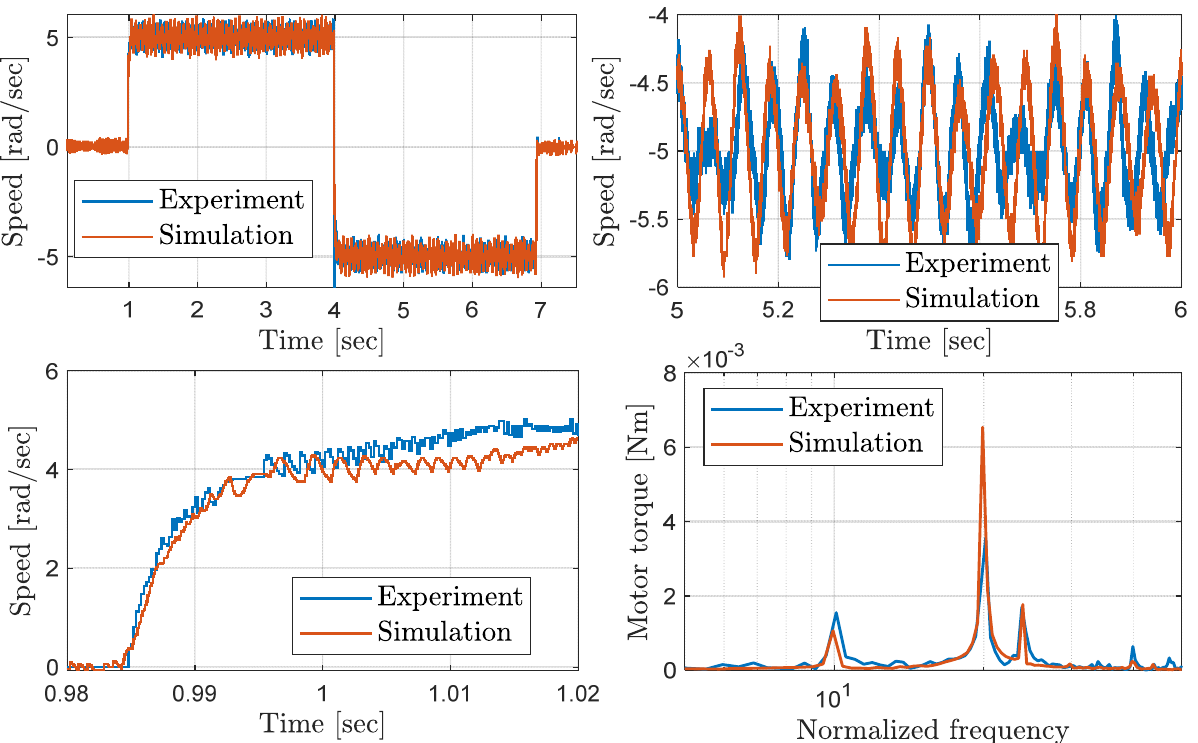
Figure 13. Response to Test 5 (closed loop on speed and currents, disengaged brakes, square-wave speed demand ± 5 rad/sec). FFT analysis is performed on quadrature current signal (proportional to torque) and frequencies are normalized with the steady-state mechanical frequency (0.8 Hz).